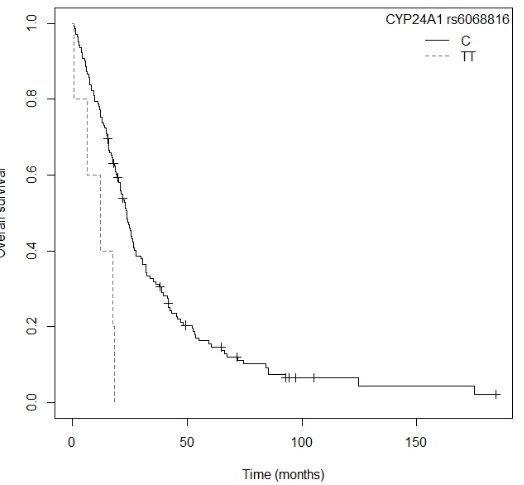
Figure 5. Kaplan–Meier plot of overall survival curves with the C allele of the CYP24A1 rs6068816 gene polymorphism in the non-resected NSCLC subgroup.